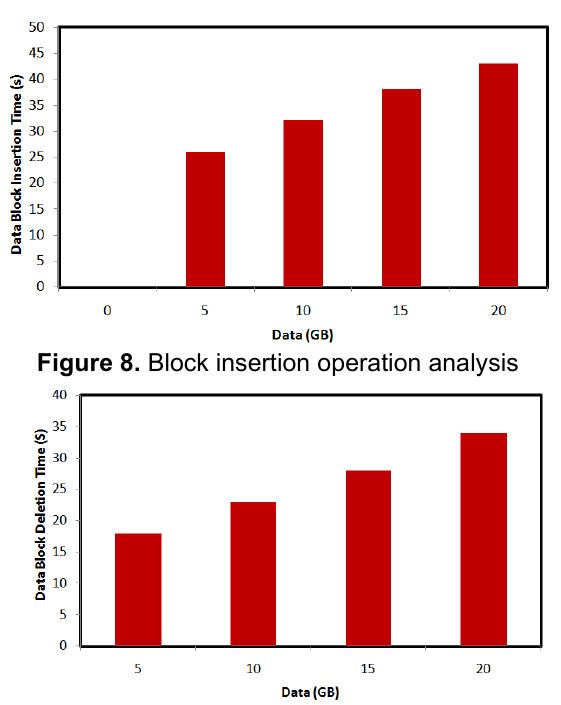
Figure 9. Block deletion operation